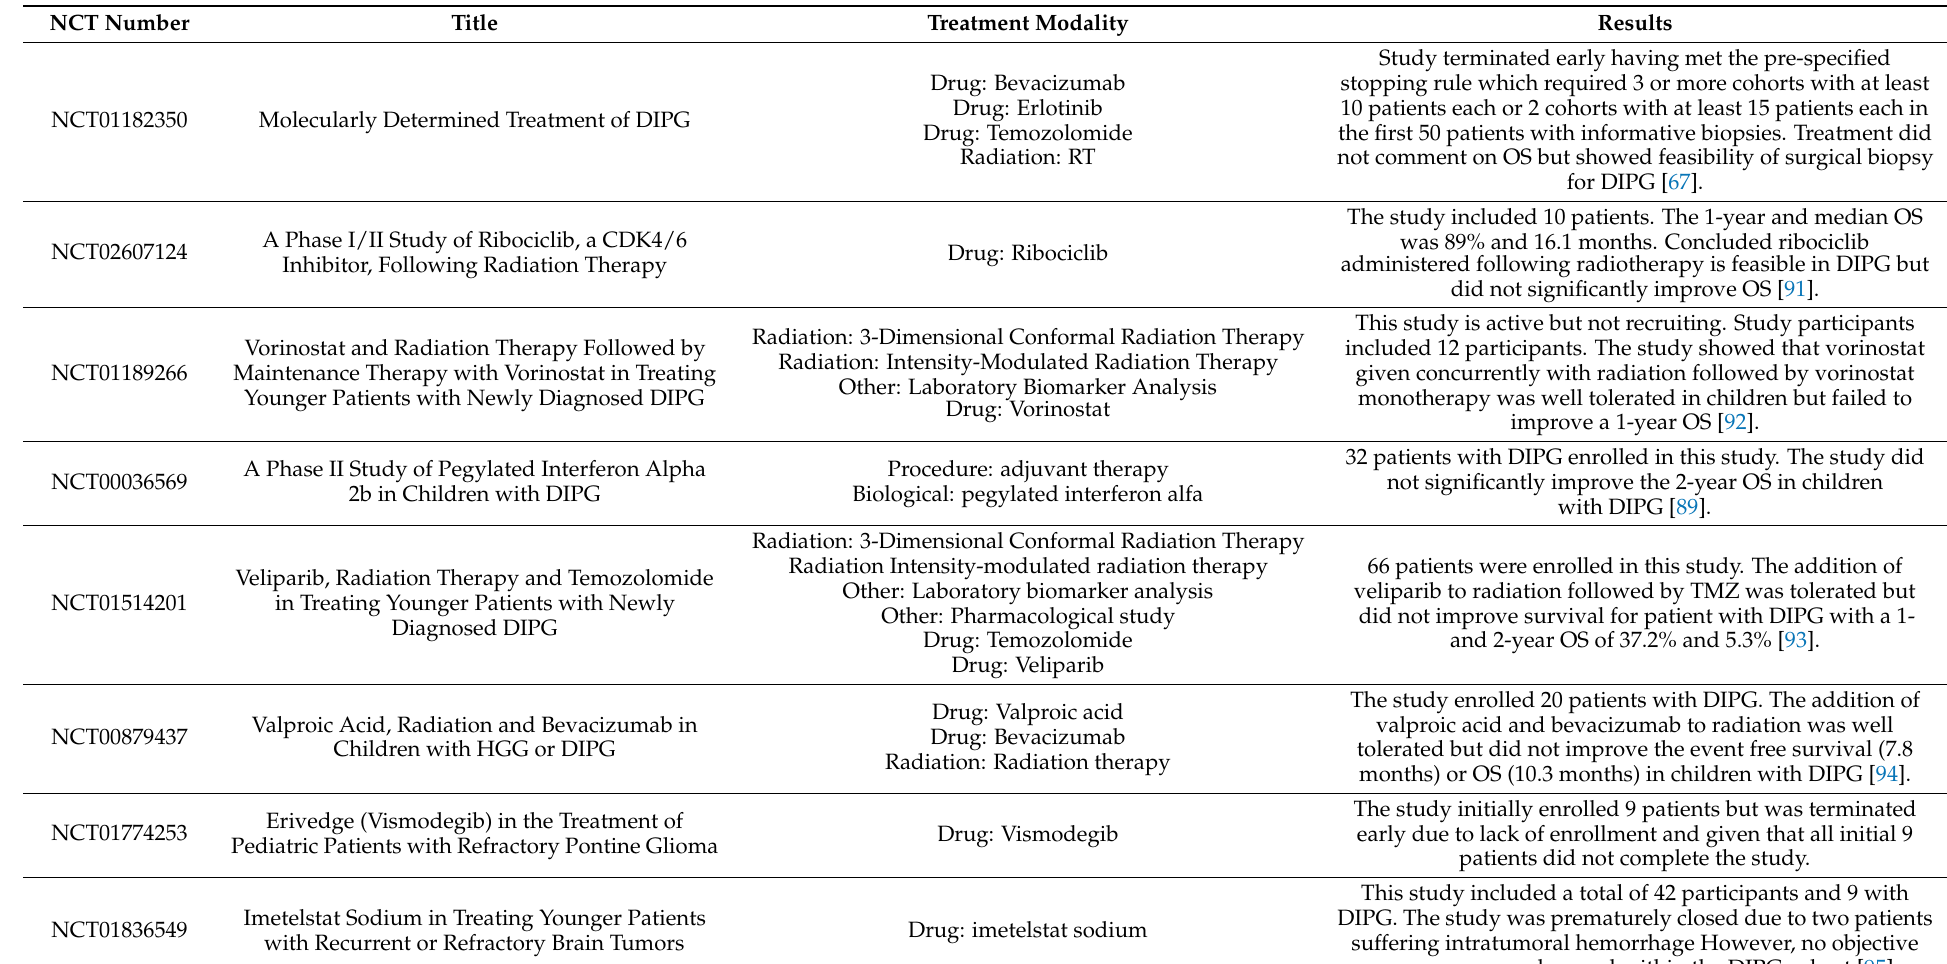
Table 3. Clinical trials for children with diffuse intrinsic pontine glioma with results available as found on www.Clinicaltrials.gov as of 12 January